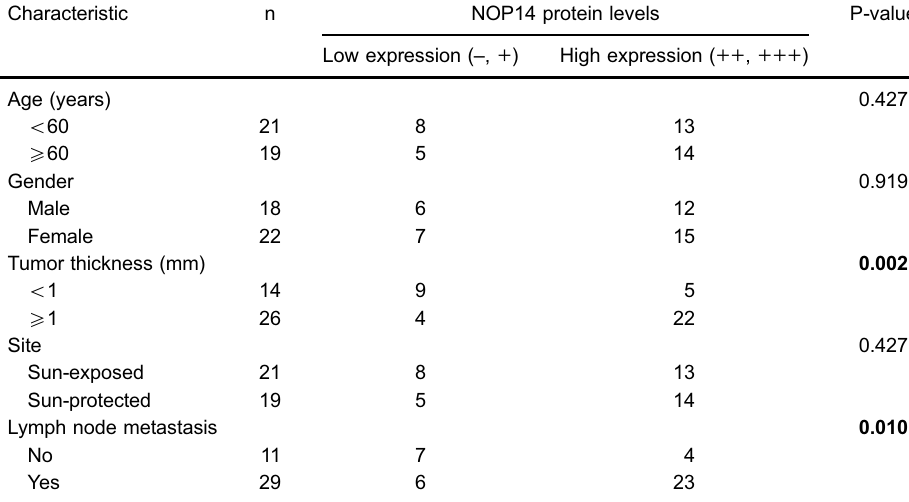
Table 1. Correlation between nucleolar protein 14 (NOP14) protein levels and clinicopathological characteristics of patients with melanoma. Characteristic